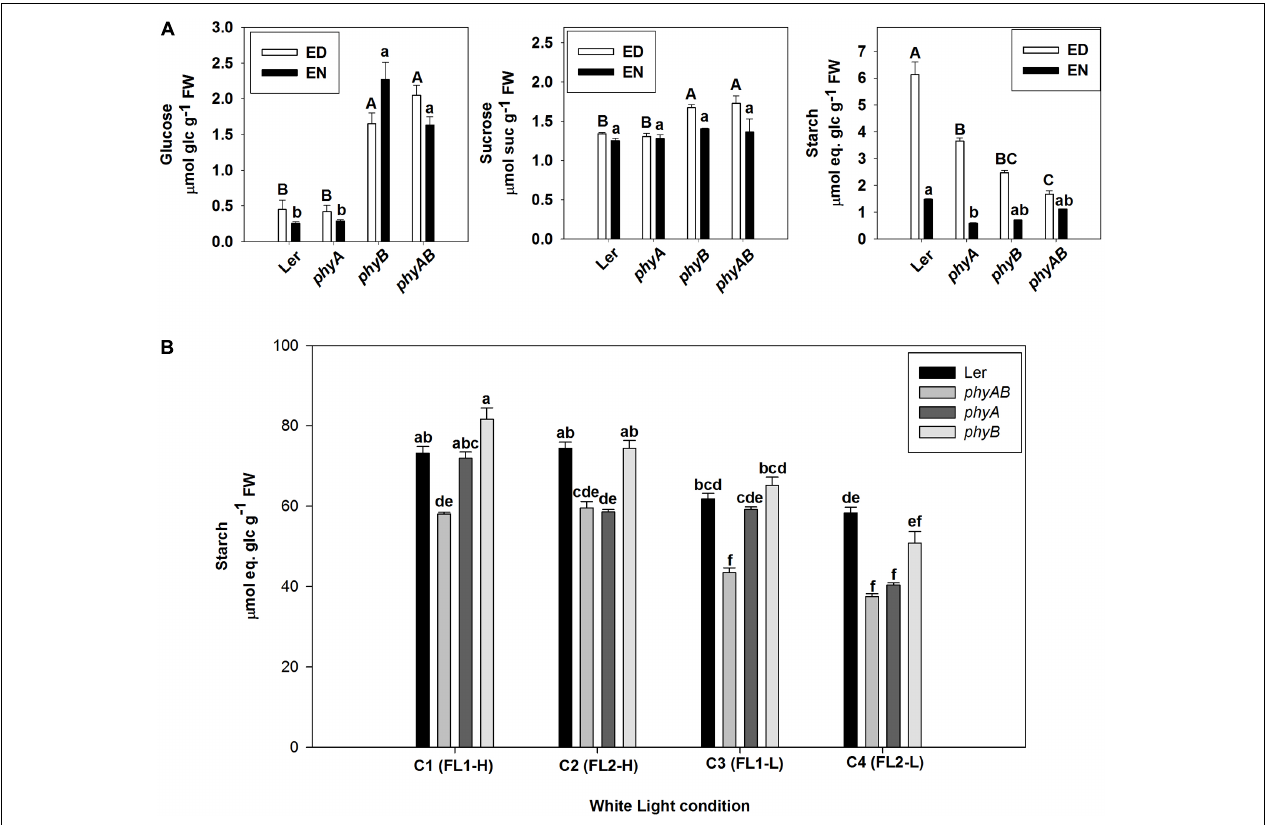
FIGURE 3 | Starch and soluble sugar levels in phyA , phyB , phyAB, and WT grown in different light conditions. (A) Glucose, sucrose, and starch at ED and EN in plants grown under red light. Results are mean ± SE of measurements made on four biological replicates. (B) Starch at ED in plants grown under four white light conditions. Results are mean ± SE of measurements made on three biological replicates. Means of the genotype ∗ light condition population were compared by one-way ANOVA with post hoc Tukey HSD test at P < 0.05. Significant differences ( p < 0.05) are indicated by different